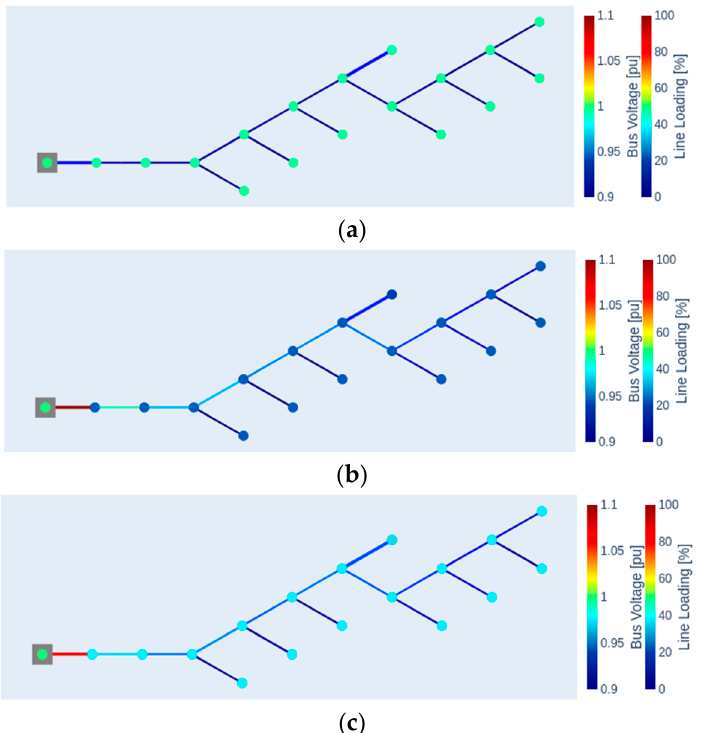
Figure 6. Calculated operating parameters plotted on the graph of the modified IEEE 34-bus feeder for various simulation experiments. ( a ) Normal operating condition; ( b ) heavy load condition (non-control); ( c ) heavy load condition (secondary QU control).